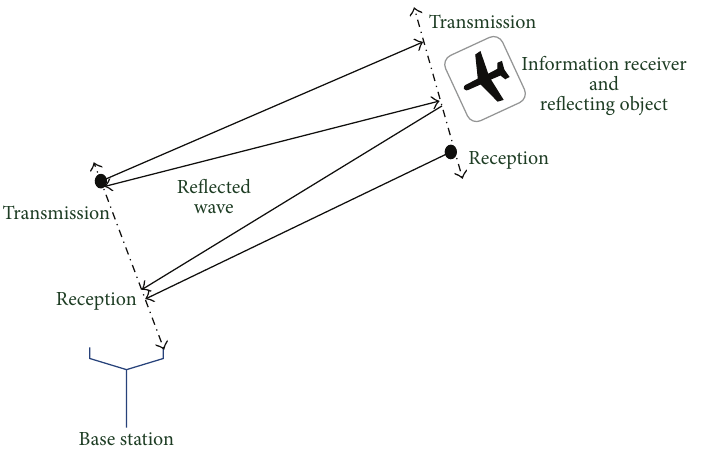
Figure 3: The schematic of communication and ranging